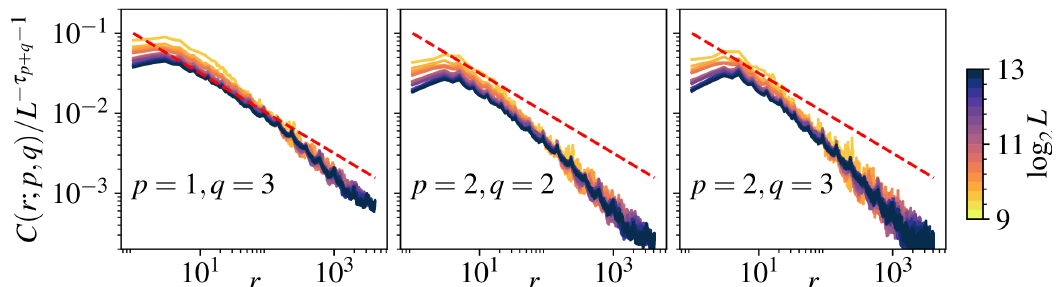
Figure 4: Power law decay of multifractal correlations. Multifractal spatial correlations C ( r ; p , q ) in space shown as a function of the distance r for different values of ( p , q ) , where the collapse of the data suggests an algebraic scaling form C ( r ; p , q ) ∼ L − τ p + q − 1 r − b p , q . The evident algebraic decay of the correlations is faster than for the previously studied critical multifractal states (red dashed lines).